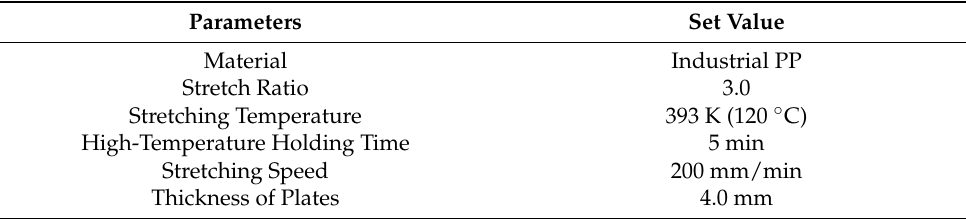
Table 1. Stretching process parameter of performance-optimized multi-axial geogrid.